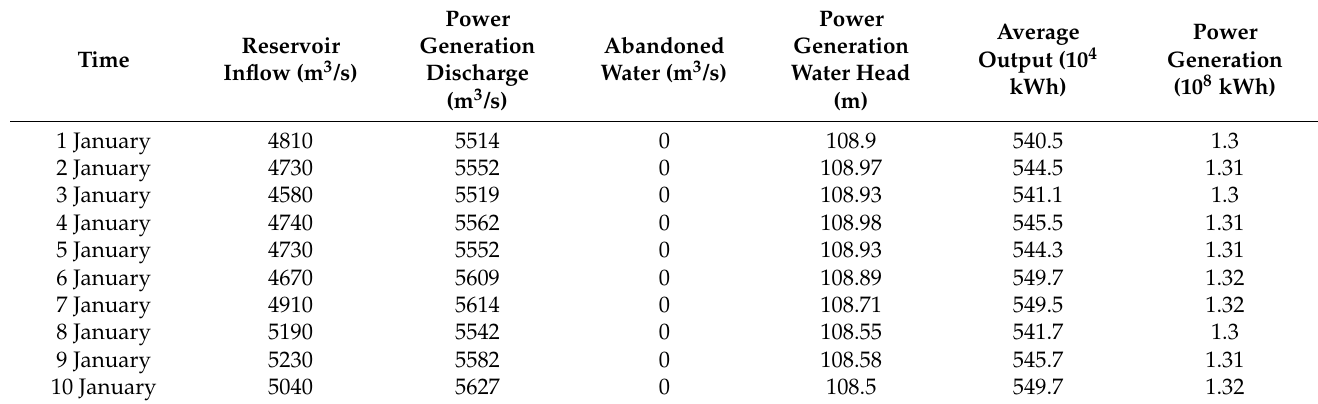
Table 9. Implementation effect statistics of operation plan for TG reservoir for first 10 days of January (daily period).